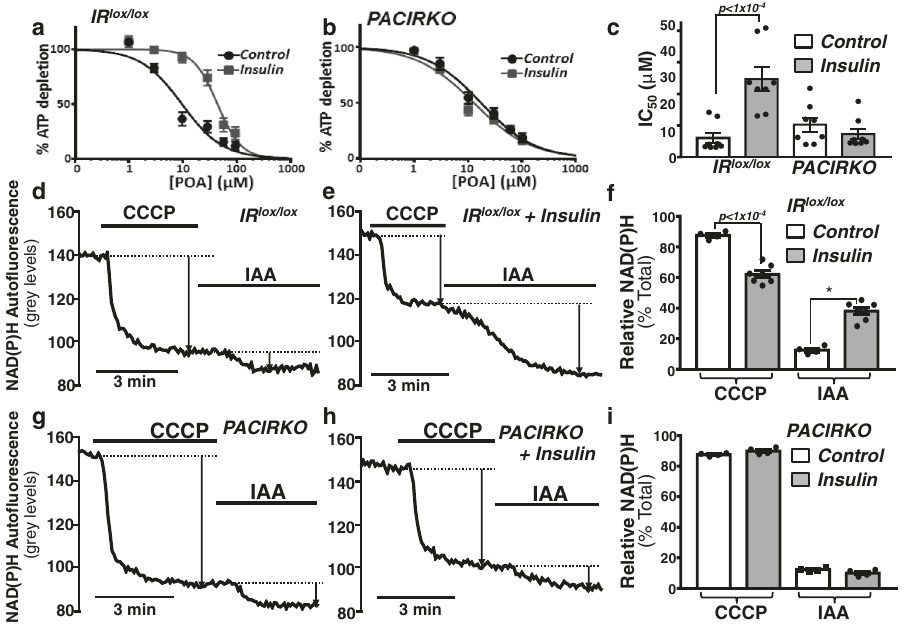
Fig. 7 Insulin-mediated protection of POA-induced ATP depletion and switch from mitochondrial metabolism to glycolysis was abolished in PACIRKO mice. POA concentration-response curves for ATP depletion in the absence and presence of insulin (10 nM) in pancreatic acinar cells isolated from IR lox/lox ( a ) and PACIRKO mice ( b ) and corresponding mean IC 50 values (±SEM) ( c ). Mean data are from eight separate experiments. Signi fi cance (exact p values as indictated) was determined by repeated measures one-way ANOVA with Sidak ’ s multiple comparisons. NADH auto fl uorescence was used to assess the relative mitochondrial vs glycolytic metabolism in pancreatic acinar cells isolated from IR lox/lox ( d , e ) and PACRIKO mice ( g , h ). Sequential background- subtracted images were acquired every 5 s (500 ms exposure), and changes in NADH auto fl uorescence were quanti fi ed as raw fl uorescence grey levels. To determine the relative mitochondrial and glycolytic contributions to NADH auto fl uorescence, the cells were treated with 4 μ M CCCP and then 2 mM iodoacetate (IAA), respectively, and responses were normalised to the total ( f , IR lox/lox ; i , PACIRKO). Mean data (±SEM) from four separate experiments for each experimental condition, except IR lox/lox with insulin ( n = 7). Signi fi cance (specifc p values as indicated) was determined by either